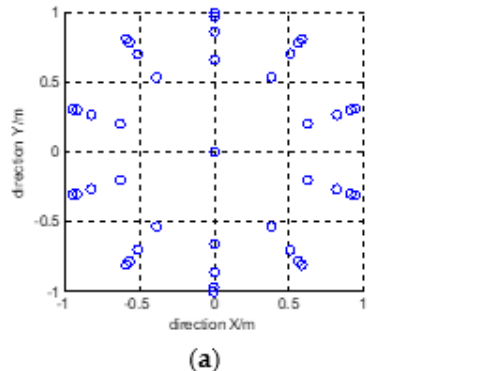
Figure 6. Schematic diagram of virtual source placement (virtual sources); ( a ) Top view; ( b ) Front view. The sound pressure level is calculated at di ff erent depths as shown in Figure 7.